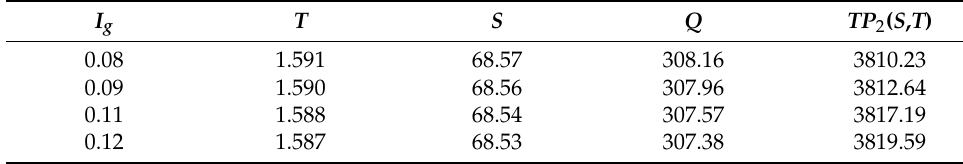
Table 12. Impact of interest gain